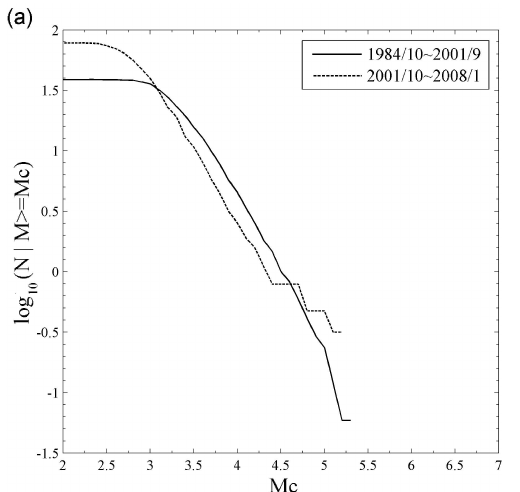
Fig. 1a. The Gutenberg-Richter (GR) frequency-magnitude dis- tribution of two successive intervals, from 1 October 1984 to 30 September 2001, and from 1 October 2001 to 31 January 2008 (UTC), respectively.